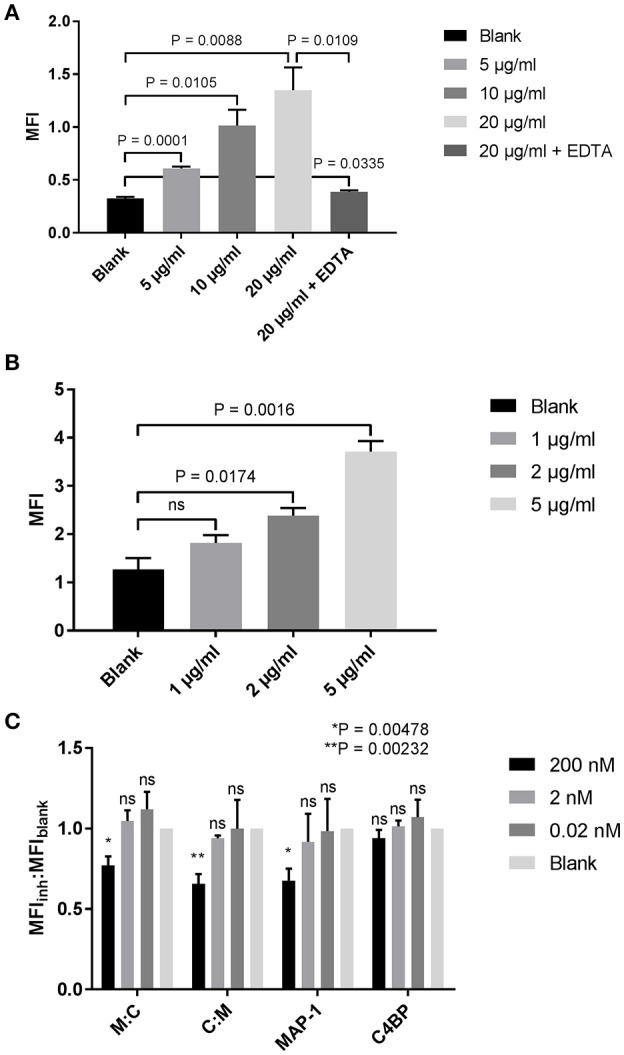
Inhibition of complement deposition on tubular proximal kidney epithelial cells. (A) HK-2 cells were incubated with increasing concentrations of rMBL at 4°C and bound MBL was determined using an anti-MBL mAb. (B) Binding of MBL results in the deposition of C4. HK-2 cells were incubated with rMBL followed by 10% MBL defect serum for 1 h at 4°C. Bound C4 was determined using an anti-C4c pAb. (C) rMBL-mediated C4 deposition after MAP-1:C4BP1−5 (M:C), C4BP1−5:MAP-1 (C:M), rMAP-1 or full length C4BP co-incubation with 10% MBL defect serum. Inhibition is reported as the ratio of the MFI of the inhibitor to the MFI of the bank (MFIinh:MFIblank). Significance was tested for each concentration of the inhibitors compared to the blank. Data are reported as the mean ± SEM of three independent experiments.